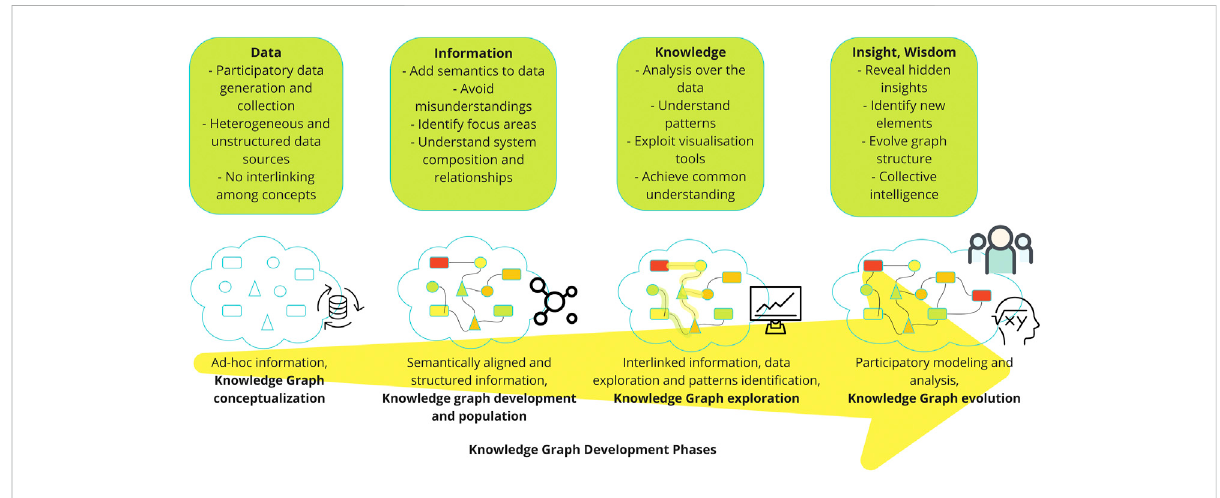
FIGURE 2 Knowledge Graph Development Phases aligned with a Systems Innovation